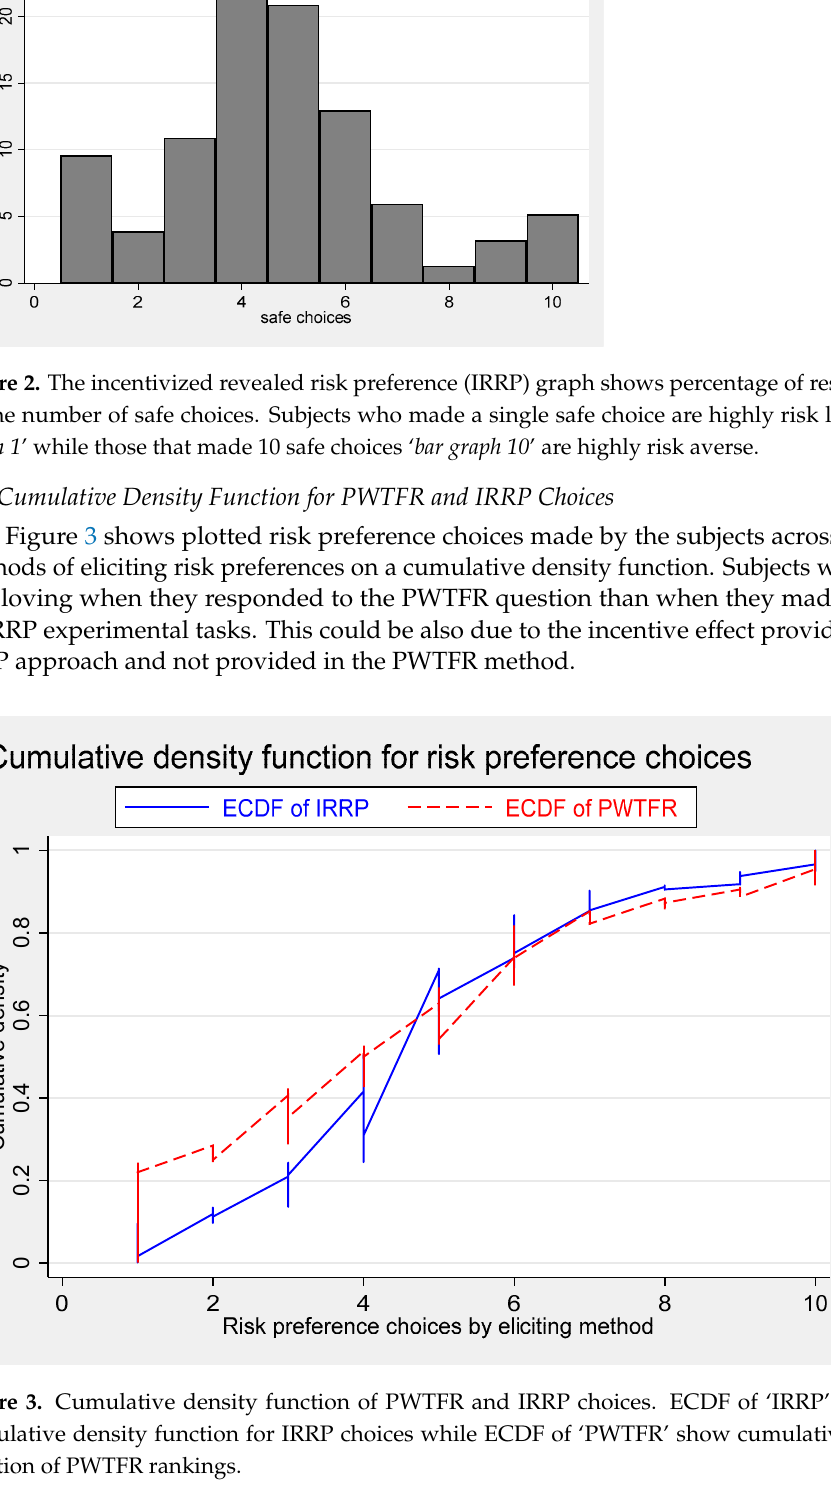
Figure 3. Cumulative density function of PWTFR and IRRP choices. ECDF of ‘IRRP’ represent cumulative density function for IRRP choices while ECDF of ‘PWTFR’ show cumulative density function of PWTFR